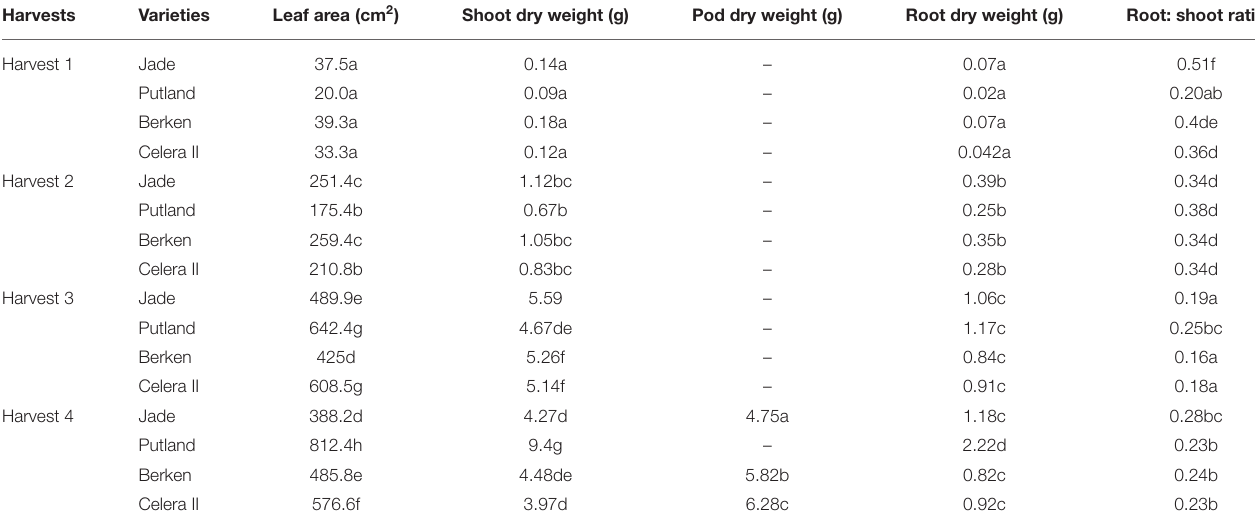
TABLE 1 | Leaf area development and accumulation of above and below ground biomass in four mungbean varieties with contrasting maturities. Harvests